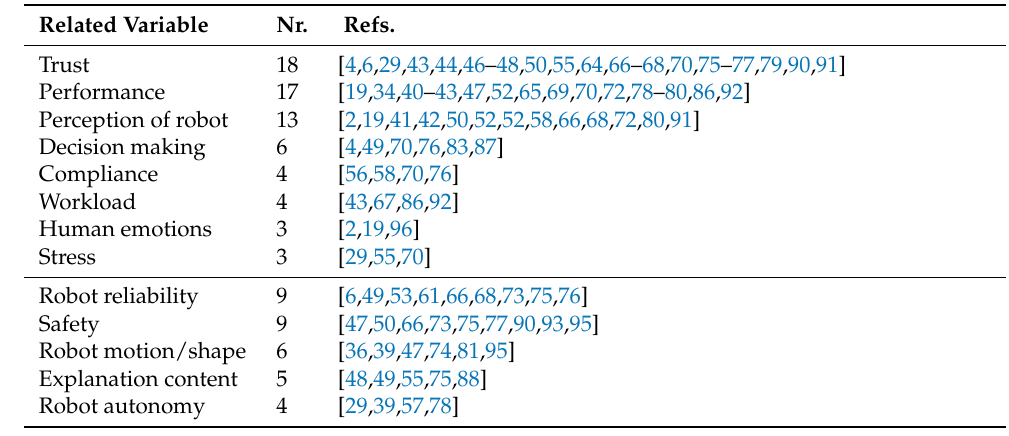
Table 3. Summary of variables measured or manipulated in user studies in the application area of transparent HRI. The top lists human-related variables while the bottom focuses on robot-related variables.